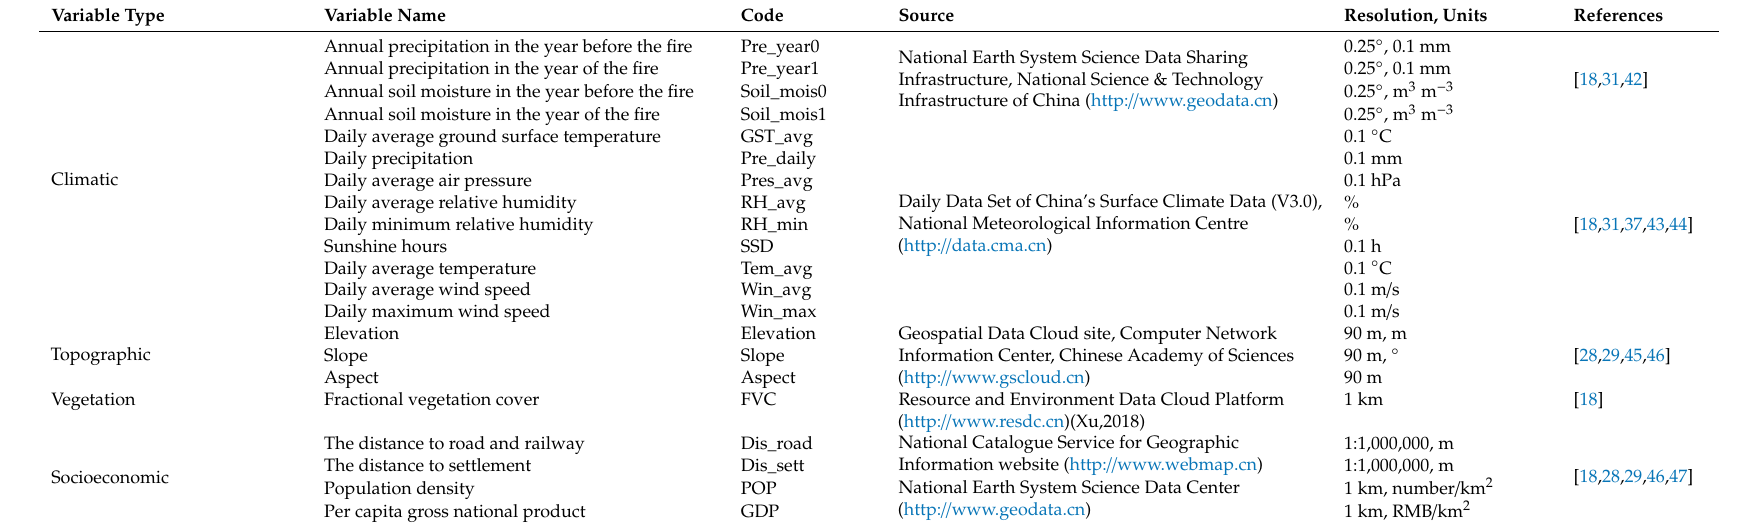
Table 2. Initial explanatory variables that were collected for inclusion as forest fire